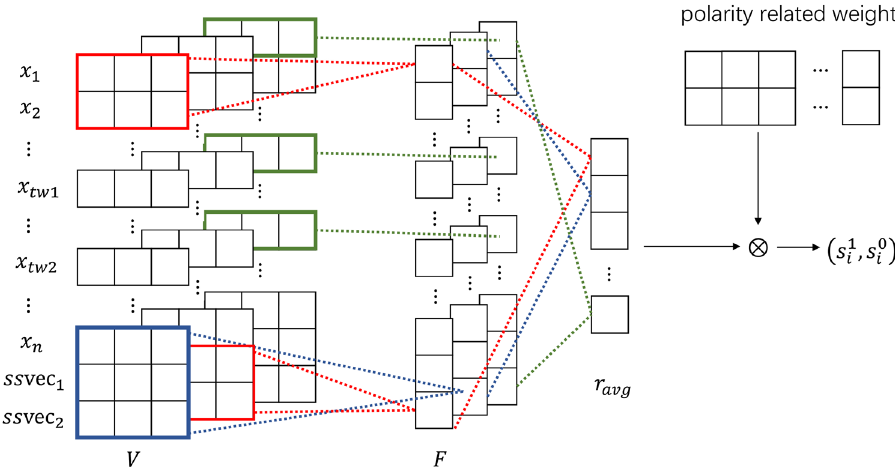
Fig. 1 The architecture of